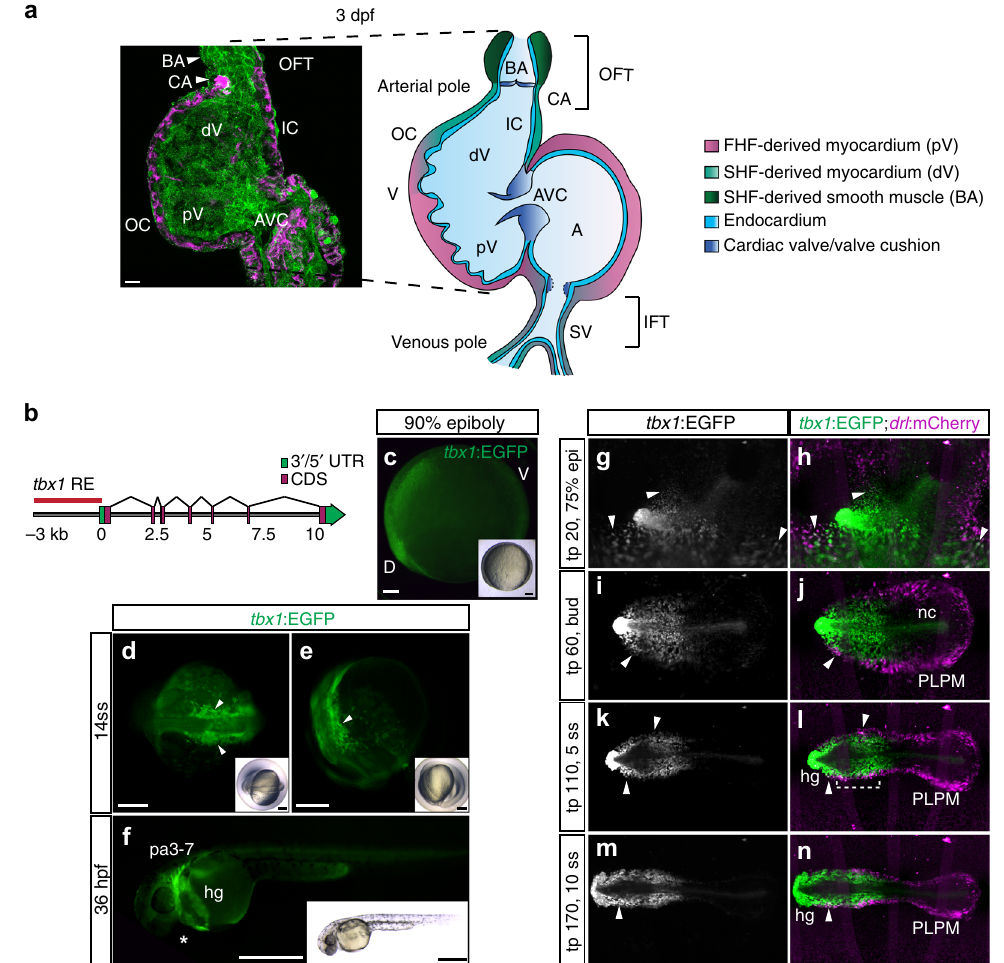
Fig. 1 tbx1 reporter expression and lineage contribution in the cardiopharyngeal fi eld and ALPM. a Confocal Z -projection and schematic representation of a 72-hpf zebra fi sh heart with two chambers, the ventricle (V) and atrium (A) separated by a valve at the atrioventricular canal (AVC). The isolated heart is stained for MHC marking the myocardium (magenta) and a-PKC marking all cells (green). The FHF-assigned myocardium contains the proximal ventricle (pV) and the majority of the atrium (A), SHF-assigned myocardium forms the distal ventricle (dV) and out fl ow tract (OFT), shown in magenta and green in the schematic, respectively. The OFT includes the conus arteriosus (CA), comprising the myocardial connection of the ventricle to the bulbus arteriosus (BA), and the smooth muscular BA itself. The lineage contributions to the sinus venosus (SV)/in fl ow tract (IFT) and developmental timing of IFT valve formation remain unresolved. IC: inner curvature, OC: outer curvature. b Genomic locus of the zebra fi sh tbx1 gene; the red line indicates a 3.2-kb cis - regulatory region ampli fi ed to drive reporter transgenics. c Representative tbx1 :EGFP reporter transgene expression in a dorsal/anterior fi eld during gastrulation (90% epiboly, dorsal/anterior to the left). d , e tbx1 :EGFP at 14 ss; dorsal ( d ) and lateral views ( e ) of the prospective cardiopharyngeal fi eld (CPF, arrowheads). f Lateral view of a 36-hpf tbx1:EGFP embryo with EGFP expression in the CPF-derived pharyngeal arches (pa3 – 7) and heart (asterisk). EGFP expression also marks the prechordal mesoderm-derived hatching gland (hg). c – f Insets depict bright- fi eld images of the respective fl uorescent images. g – n Mercator projection of representative stages from panoramic SPIM-imaged tbx1:EGFP ; drl:mCherry double-positive transgenic embryos ( n = 3); dorsal views. tbx1 :EGFP expression is con fi ned to the anterior of the embryo, with no EGFP signal in the posterior LPM (PLPM). Expression in the notochord (nc) and hatching gland (hg) is likely related to early prechordal plate activity of the reporter. Note the double-positive cells at the outermost domain of the tbx1 :EGFP- positive anterior cell population (arrowheads and bracket). Scale bars 10 μ m ( a ), 100 μ m ( c ), 200 μ m ( d , e ), and 500 μ m ( f ). g – n Anterior to the